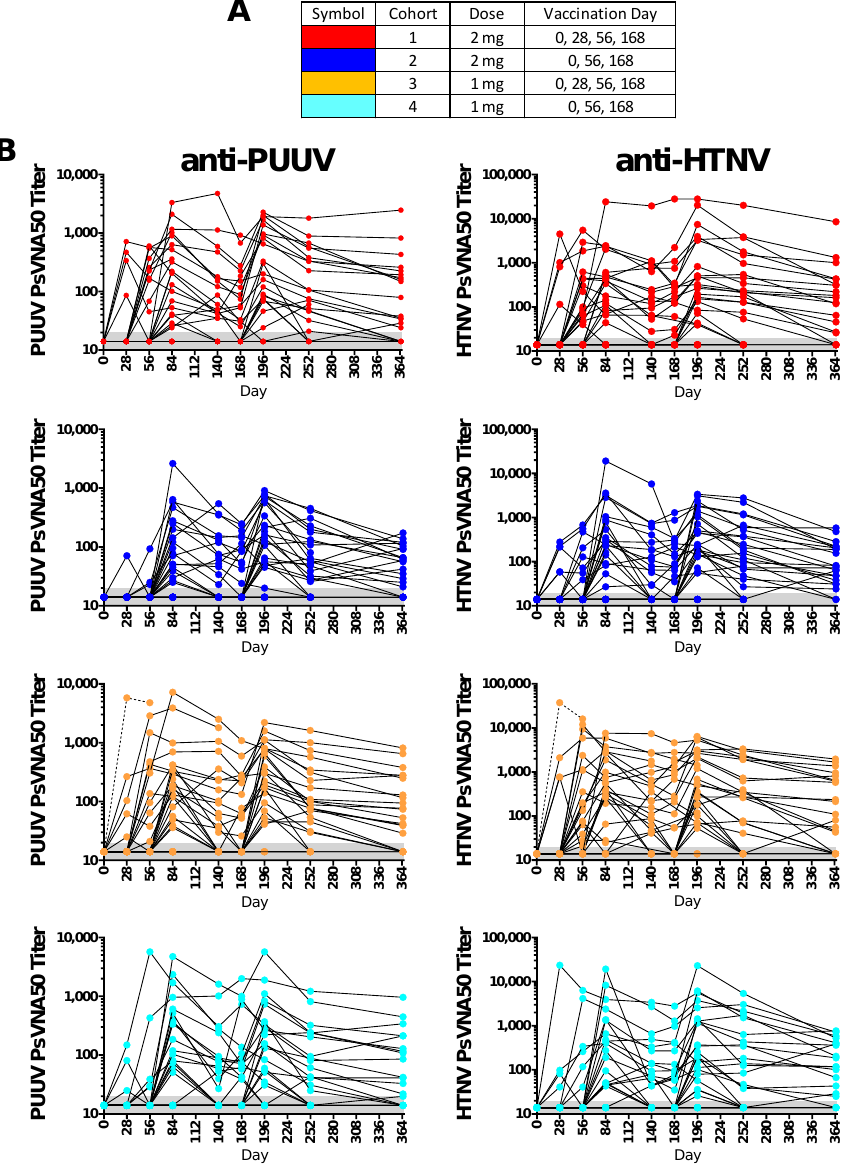
Figure 2. Pseudovirion neutralization assays (PsVNA)50 titers. Puumala virus (PUUV) and Hantaan virus (HTNV) PsVNA50 titers for each subject at each timepoint grouped by cohort. Subjects were randomized and vaccinated with the indicated amount of DNA (either 2 mg or 1 mg) on the indicated day (0, 28, 56, 168 or 0, 56 and 168). ( A ) Legend. ( B ) PUUV and HTNV PsVNA50 titers. Note that the Y-axis for PUUV and HTNV graphs are different. The limit of quantitation was a PsVNA50 titer of 20 (grey shaded area). Dashed line indicates specimens that were not included in the efficacy evaluable population.